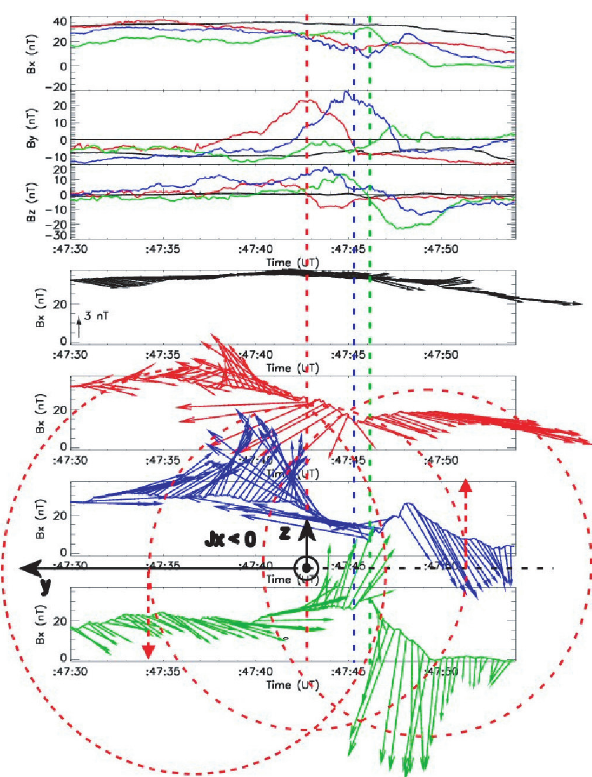
Fig. 16. 1 October 2001, event, same format as Fig. 13. Notice that B y (4) can be deduced from B y (2) via a time shift of ∼ 5s (a) . On (b) dashed red circles are tangent to the magnetic field measured by C2, at 3 successive times. Dashed lines are intended to single out the directions of the B for these